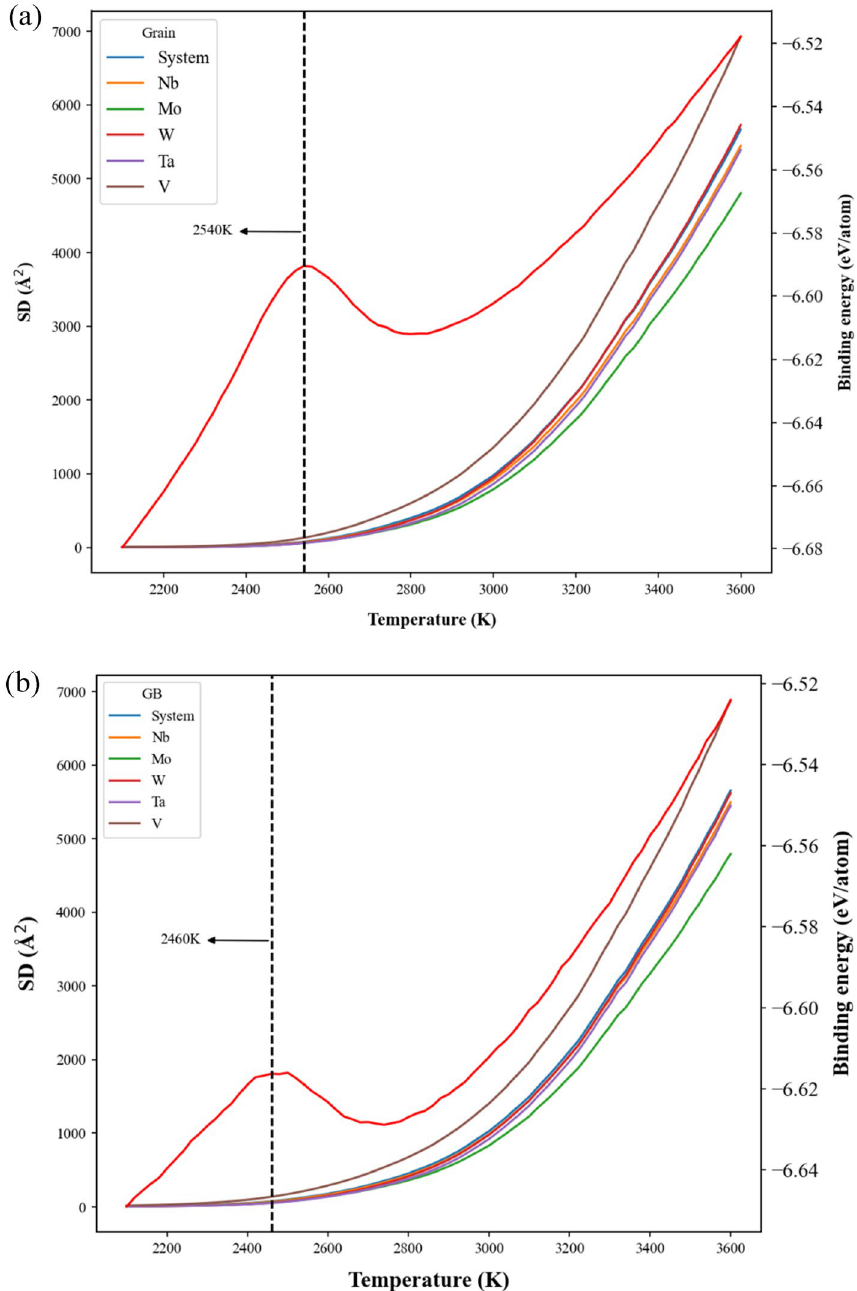
Figure 15. The binding energy and square displacement (SD) profiles of system, Nb, Mo, W, Ta, and V of ( a ) the grain atoms and ( b ) the GB atoms for the case with the average grain size of 5.2 nm during the heating